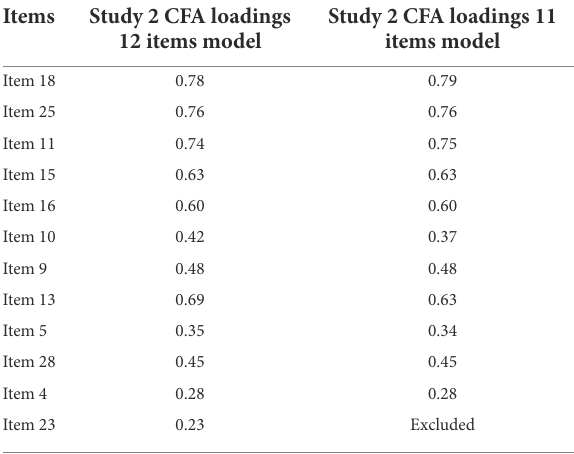
TABLE 5 Standardized CFA factor loadings of 12 items model and 11 items model (Study 2: CFA, N = 178).